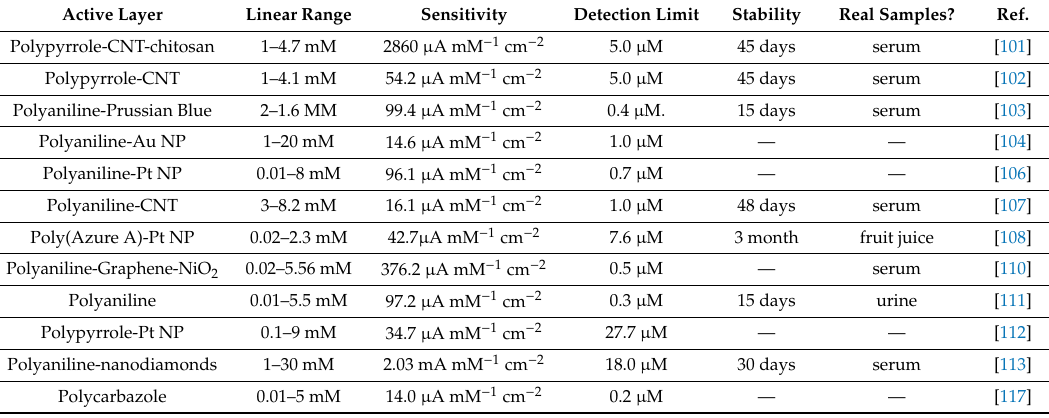
Table 2. Comparison of conducting-polymer-based glucose amperometric biosensor